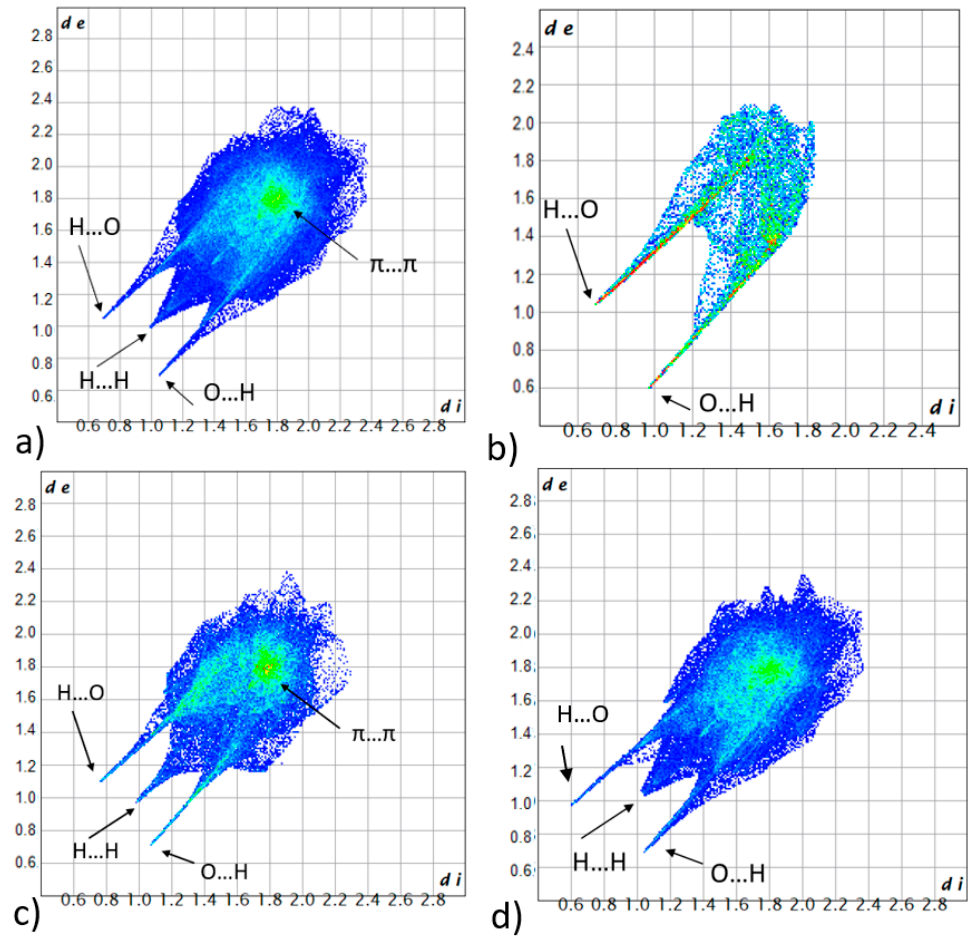
Figure 5. Overall 2D fingerprint plots of ( a ) the cocrystal and individual components ( b ) water, ( c ) THP, ( d ) ENT.